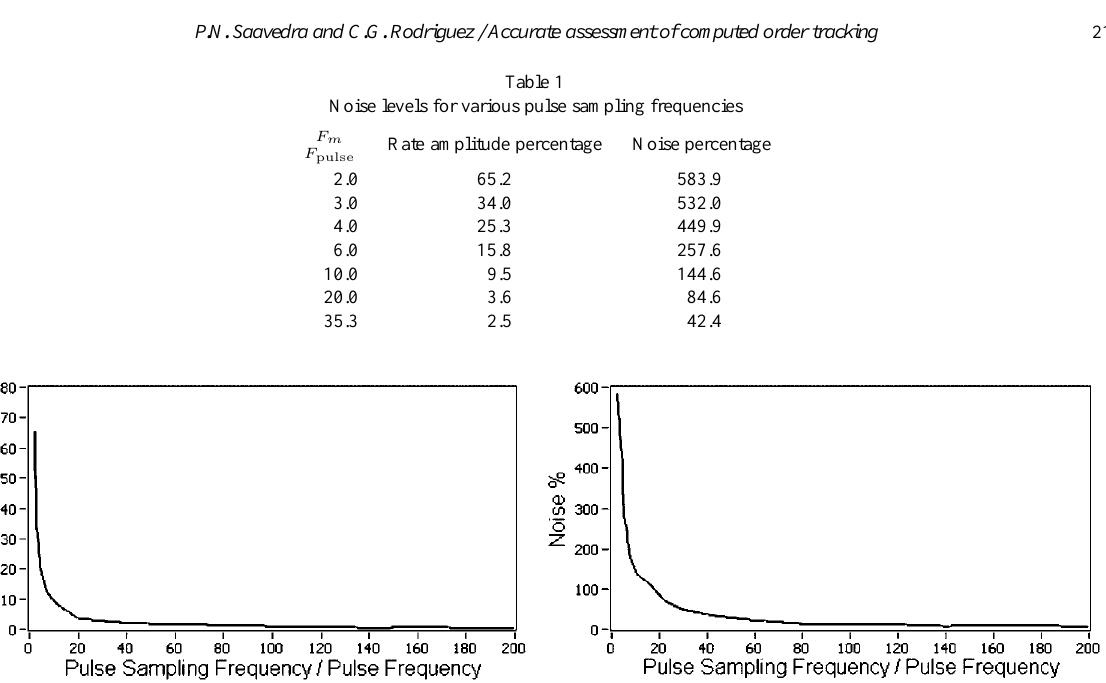
Fig. 7. Noise levels due to the pulse sampling frequency.